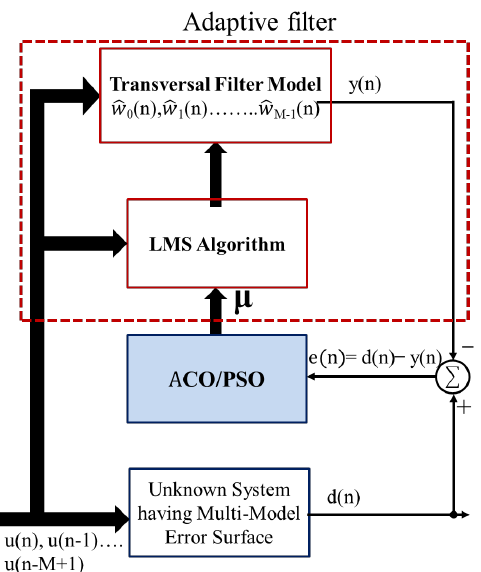
Figure 3: Proposed Model, where u(n) is the input applied to the adaptive filter, y(n) is the output of adaptive filter, d(n) is the desired response and e(n) is the estimated